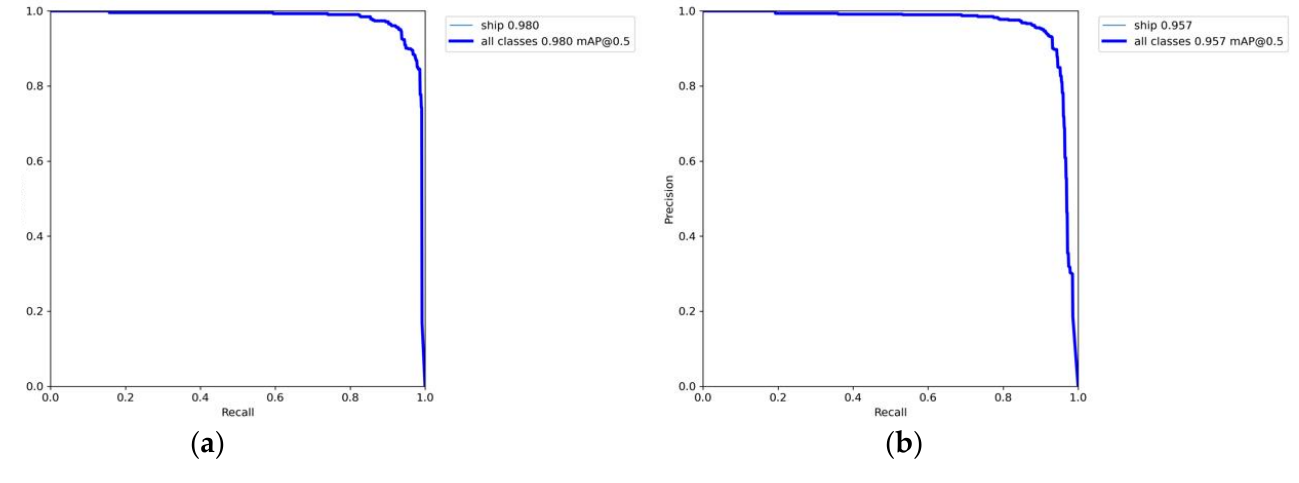
Figure 12. Comparison of the P–R curves of the two detection algorithms on SSDD: ( a ) P-R curve of FLNet on SSDD dataset; ( b ) P-R curve of YOLO V5 on SSDD dataset.